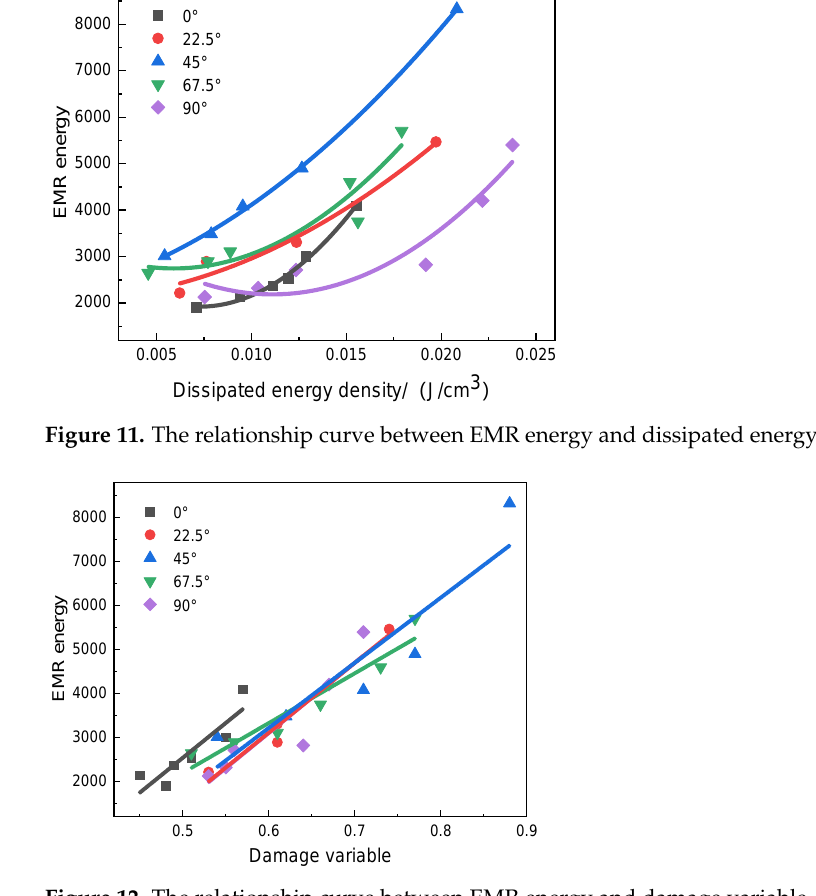
Figure 12. The relationship curve between EMR energy and damage variable.